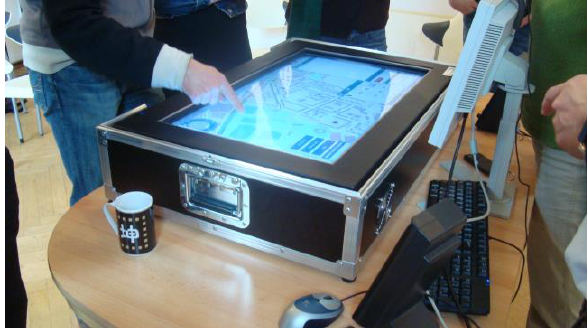
Figure 1. Stakeholders using interactive